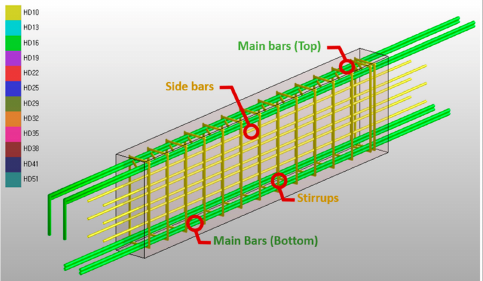
Figure 4. Example of the rebar arrangement of beam members and the name of the rebar for each part (RF, Building #101 of construction project